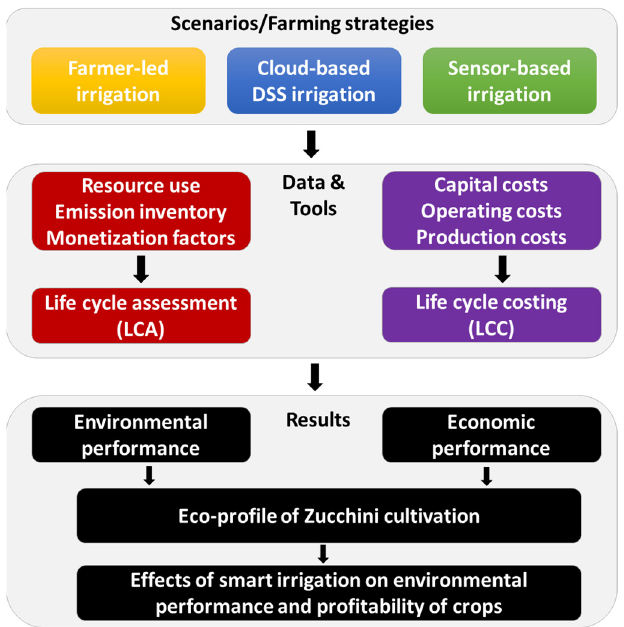
Figure 2. Framework for life cycle assessment (LCA) and life cycle costing analysis (LCC) of zuc- chini production.